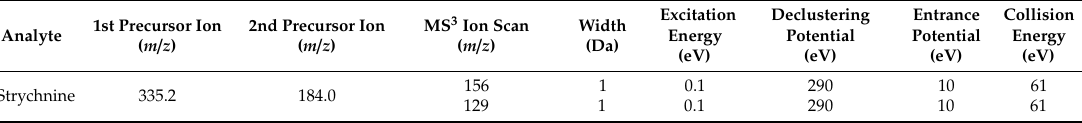
Table 3. Precursor ions of strychnine—mass spectrometry